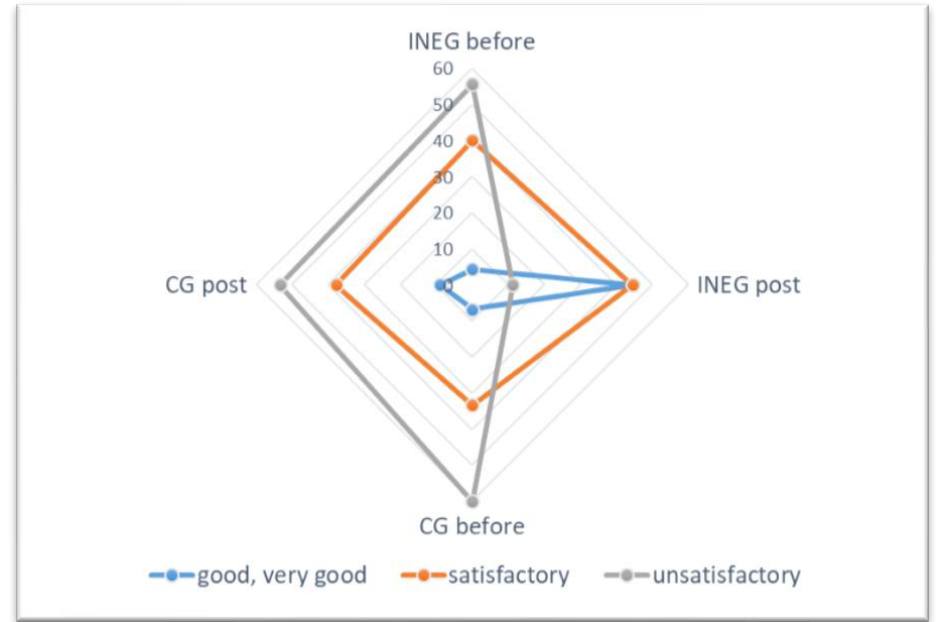
Figure 2. Assessment of nutrition knowledge among patients using the KomPAN questionnaire.